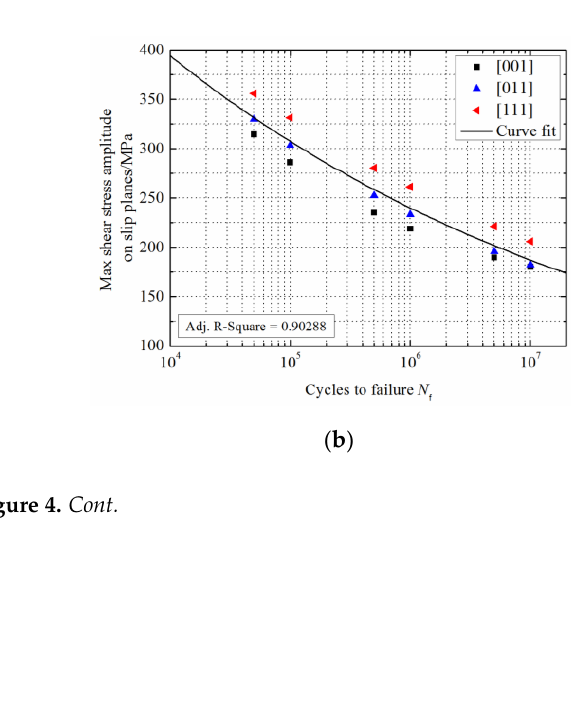
Figure 3. Fatigue life prediction for DD6 material at 700 °C using the proposed model.